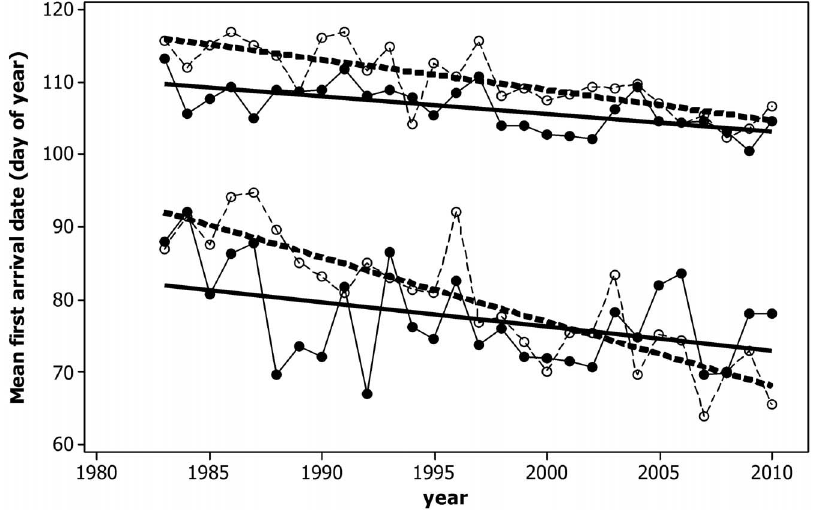
Figure 3. First arrival dates for rural (solid symbols and lines) and urban observations (open symbols and dotted lines) averaged over seven short distance migrants (lower part of graph) and 11 long distance migrants (upper part of graph) in Western Poland 1983–2010. Regression lines superimposed. Note than the same set of species was included in all years and in both habitats.